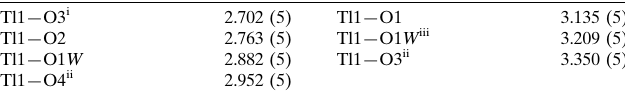
Selected bond lengths (A˚ ).